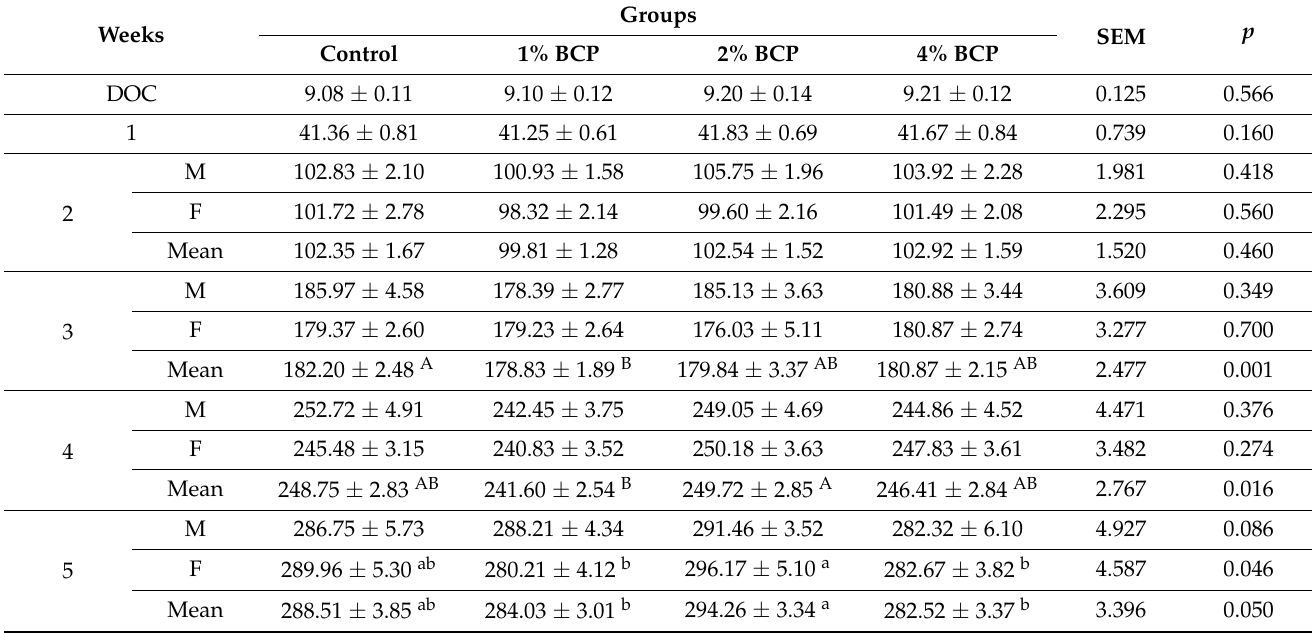
Table 2. The effect of BCP supplementation at different levels on the weekly live body weight (LBW).